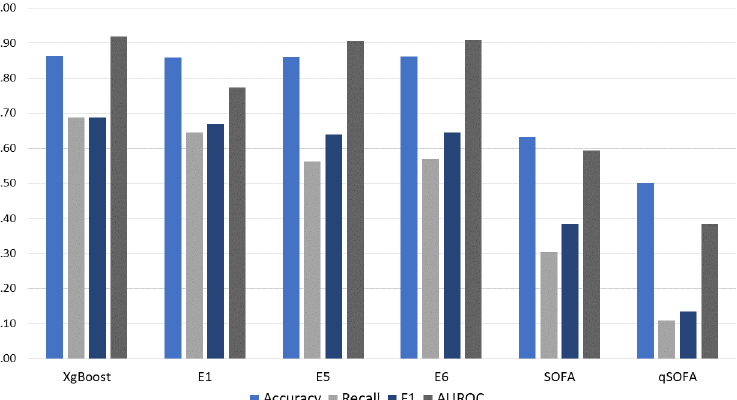
Figure 14. Summary comparison of metrics results of four ensemble models vs. SOFA and qSOFA using t = 1 h and look back features = 24